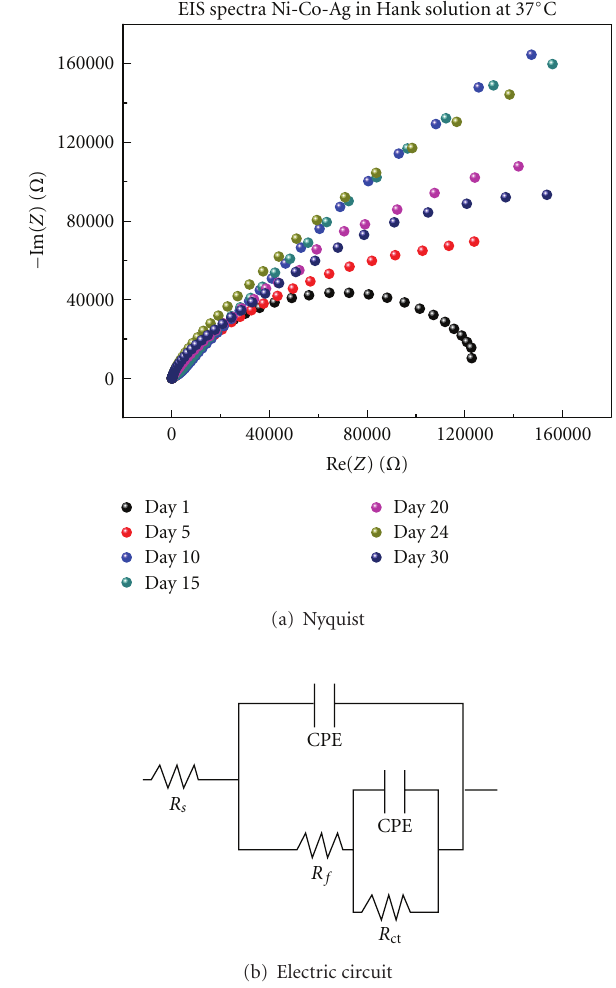
Figure 8: EIS Nyquist plot for di ff erent times of immersion and equivalent